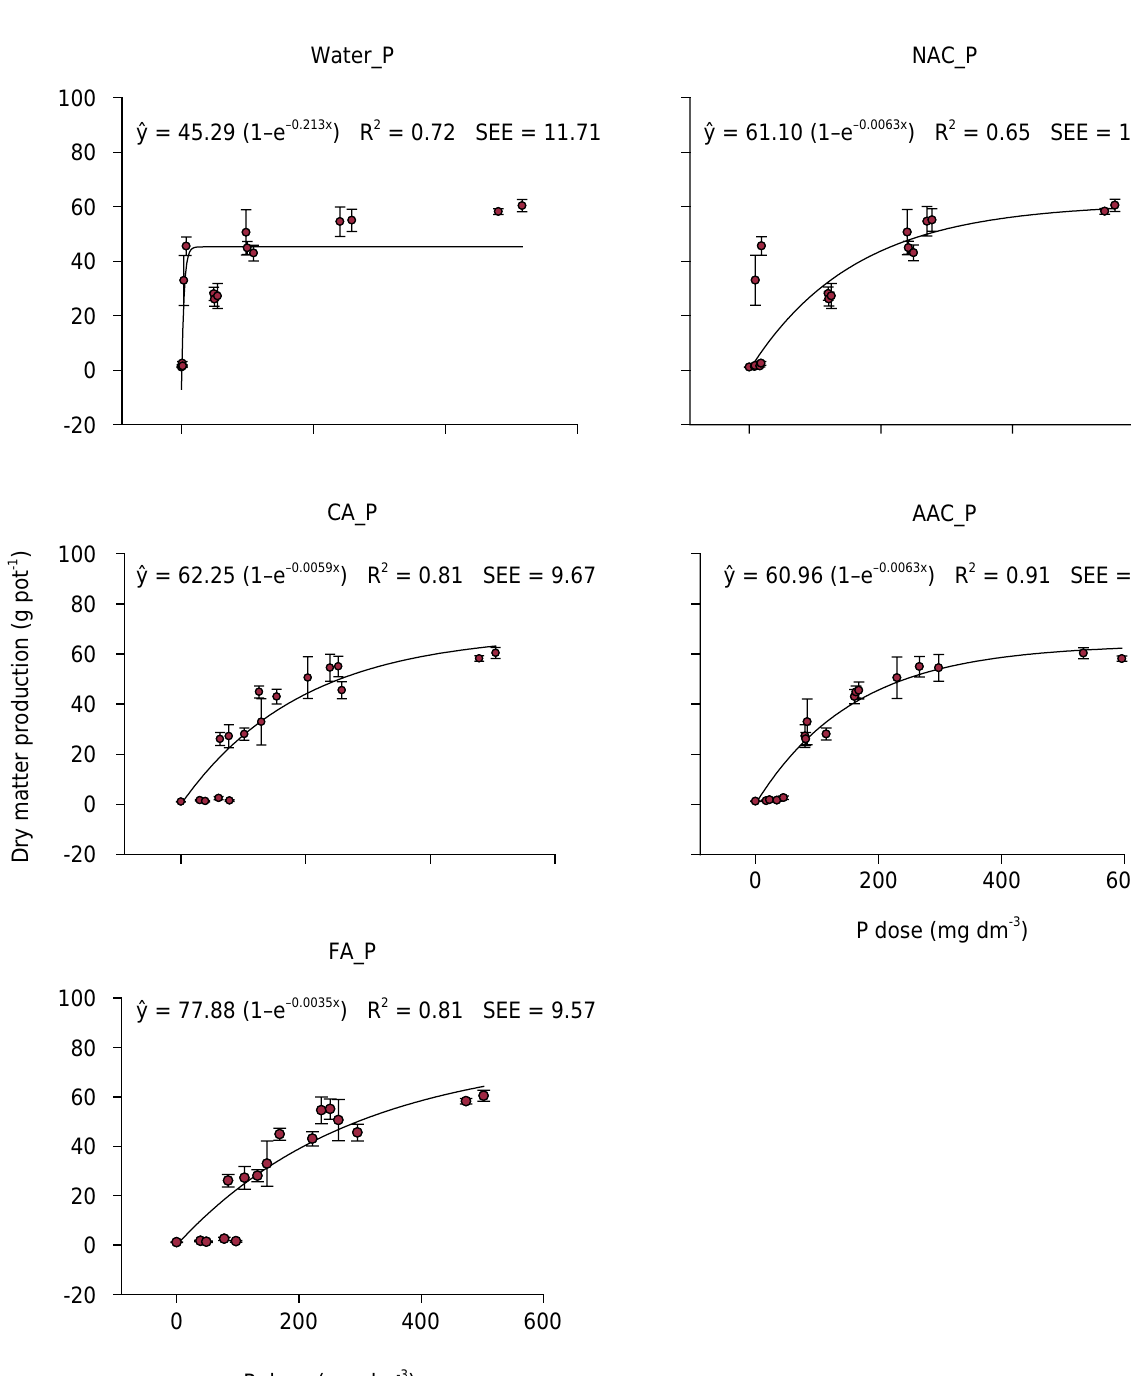
Figure 2. Mitscherlich function fitted to shoot dry matter production of corn depending on doses of soluble P in water (Water_P), neutral ammonium citrate (NAC_P), citric acid (CA_P), acid ammonium citrate (AAC_P), and formic acid (FA_P). Mitscherlich equation model: ŷ = Amax(1 – e –bx ), in which Amax is the maximum dry matter production and b is a parameter related to the shape of the curve. The variable x is the added P dose (mg dm -3 ). SEE = standard error of estimation of the model. * All adjustments were significant at